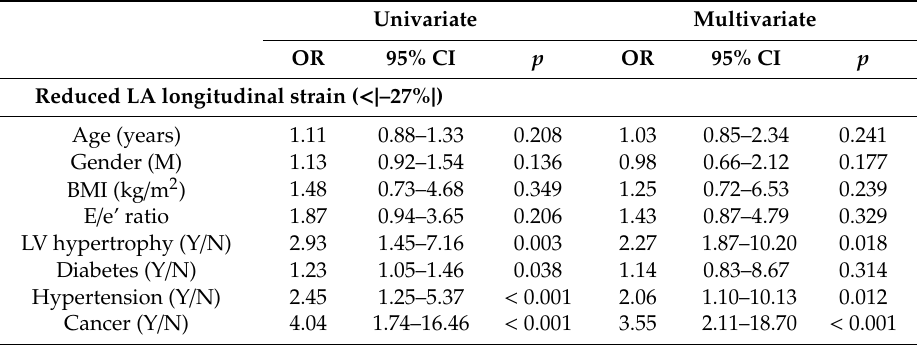
Table 4. Univariate and multivariate logistic regression